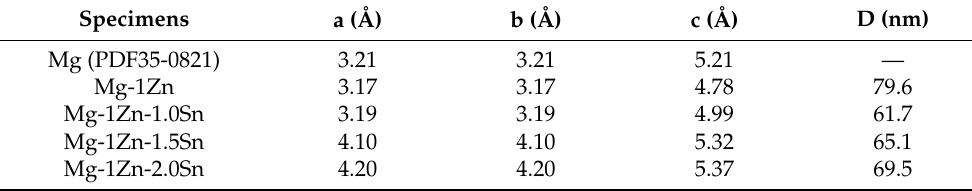
Table 3. Lattice constants of the specimens calculated from XRD